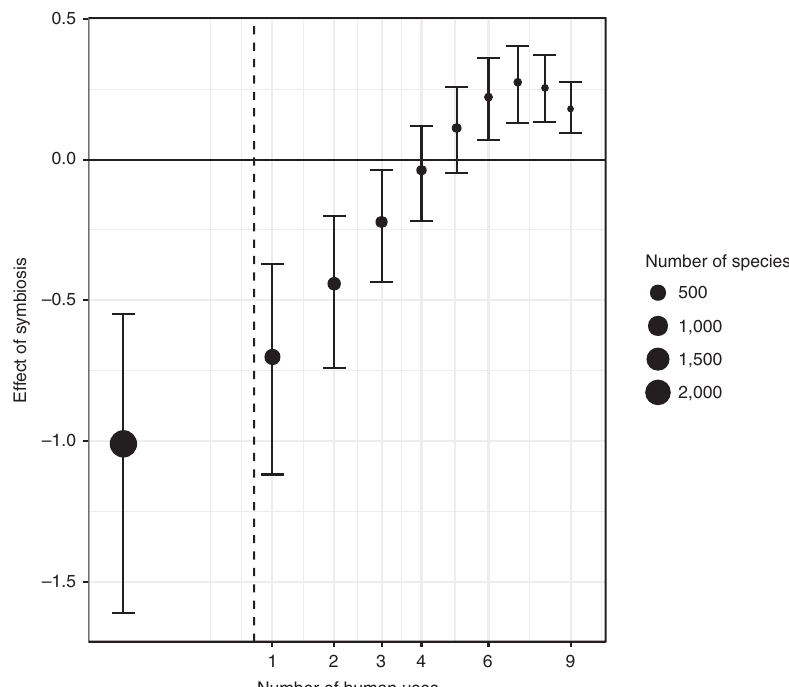
Figure 4 | The interaction between symbiosis and human uses. The size of the symbiosis effect on successful introductions at different numbers of human uses, using the full dataset. Dots represent the difference in the predicted number of non-native ranges between non-symbiotic and symbiotic species, standardised by dividing by the predicted number of non-native ranges for non-symbiotic species. The standardisation controls for the differences in the predicted number of non-native ranges between different human use levels (determined by the main effect of number of human uses), and makes the interaction easier to visualize. Error bars represent the 95% confidence interval obtained through parametric bootstrapping. The size of the dots is proportional to the number of species in the dataset with that number of human uses, showing that most species had no uses recorded in the dataset ( B 70%). The dotted vertical line represents the mean number of human uses across all species in the dataset (0.77). The x-axis is on a square root scale. Negative values mean the symbiotic species are predicted to have a lower prevalence of non-native ranges relative to non-symbiotic species. Apparent non-linearity is due to logit are important in predicting the introduction success of legumes across multiple continents and islands. Our study further highlights likely ecological costs associated with being a nitrogen-fixing species, and the potential for plant species distributions to be influenced by soil microbial biogeography at a global scale.